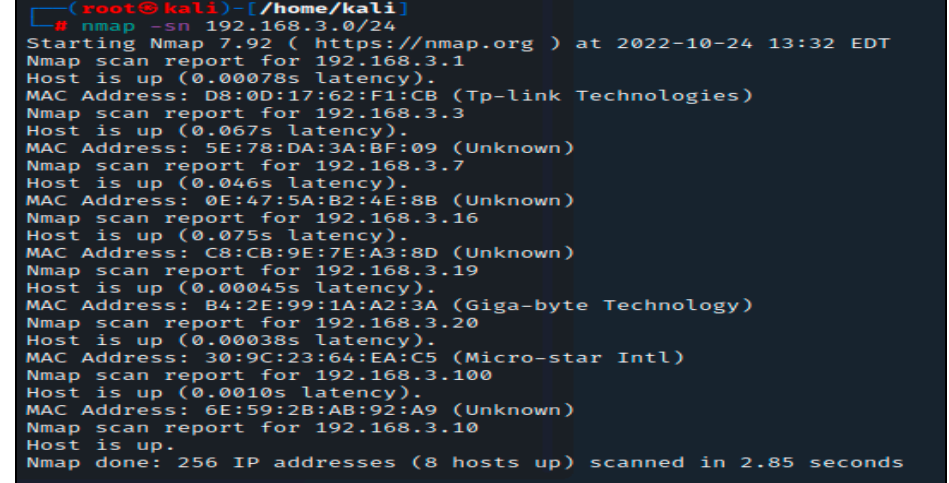
Figure 2. Nmap scan with -sn command.